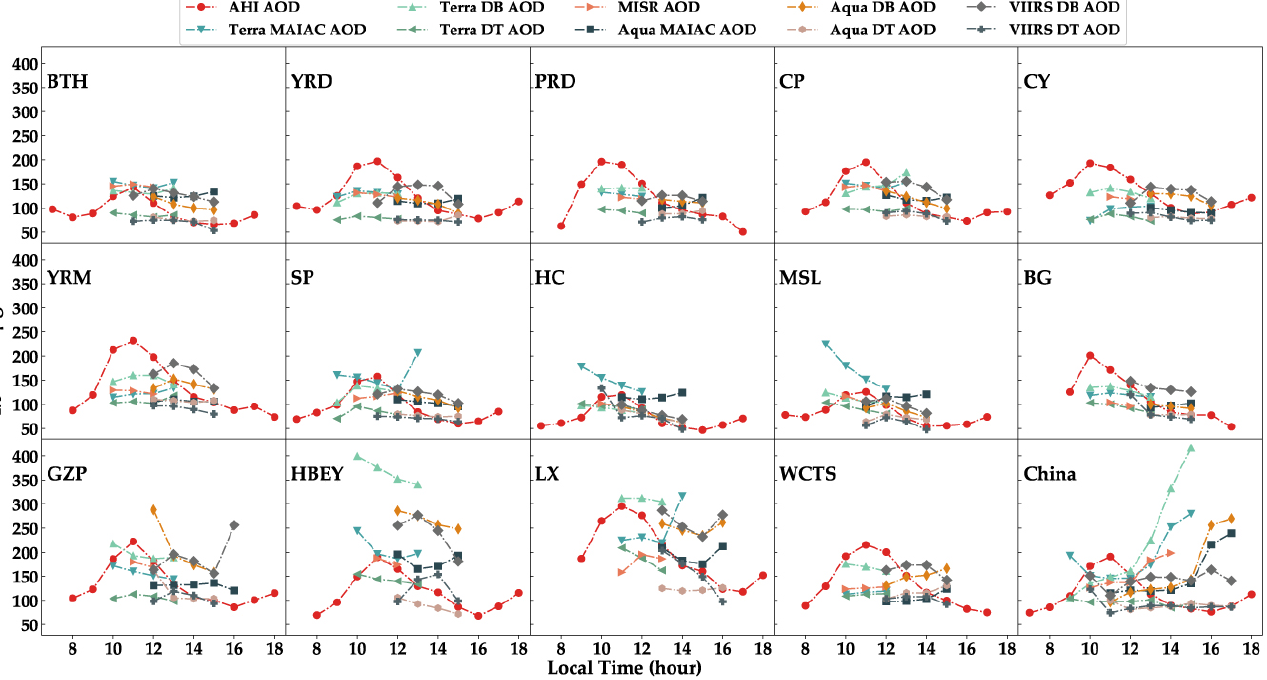
Figure 5. The daily variation of the ratio ( η ) between the near-surface PM 2.5 concentration and the LEO-GEO satellite AODs. The symbols on the graph are similar to Figure 4, except that the vertical axis is the ratio of PM 2.5 /AOD.